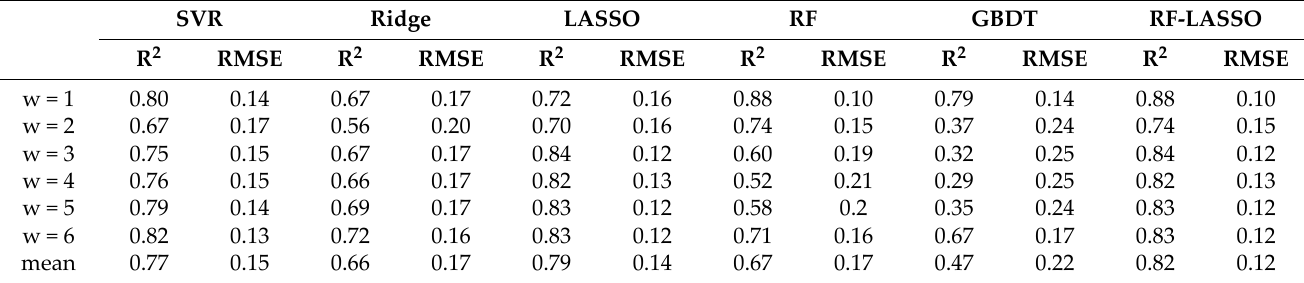
Table 3. Comparative assessment of shallow learning models in the test